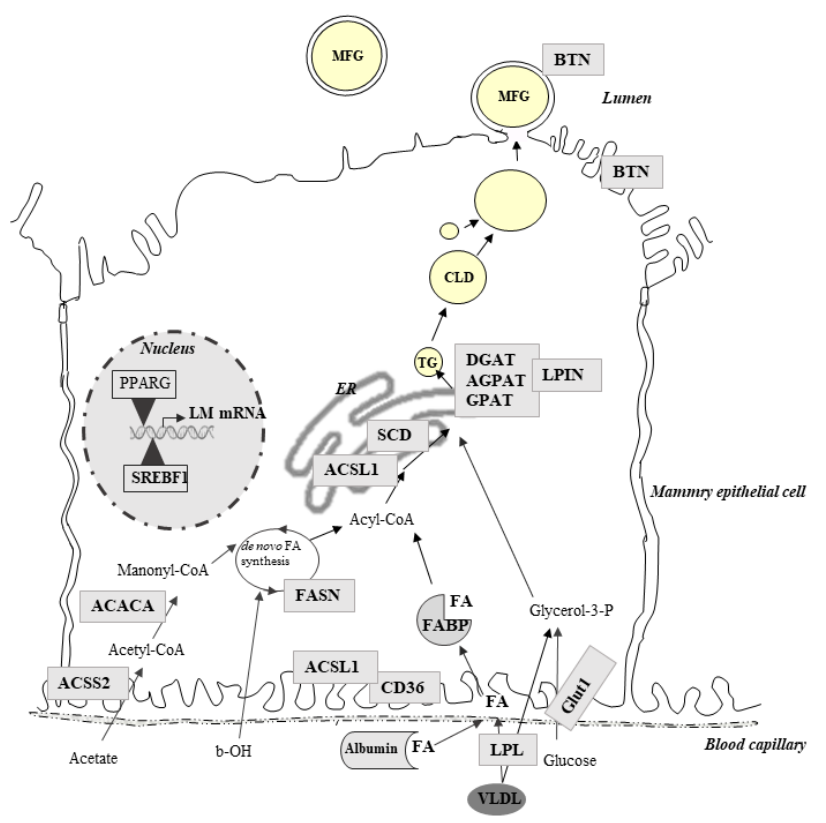
Figure 2. Milk fat synthesis in ruminant mammary epithelial cells. Key proteins are in gray boxes. ACACA: acetyl-CoA carboxylase; AGPAT: acyl glycerol phosphate acyl transferase; ACSL: acyl-